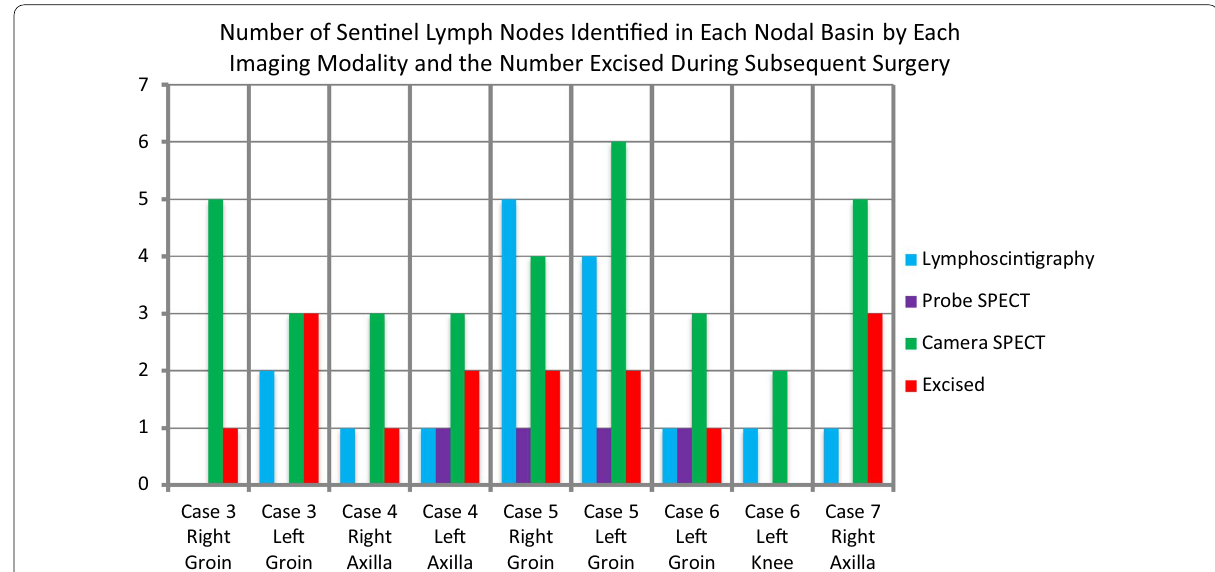
Fig. 8 Bar graph comparing, for each of nine lymphatic basins, the number of SLNs detected by each of the three imaging modalities tested and the number